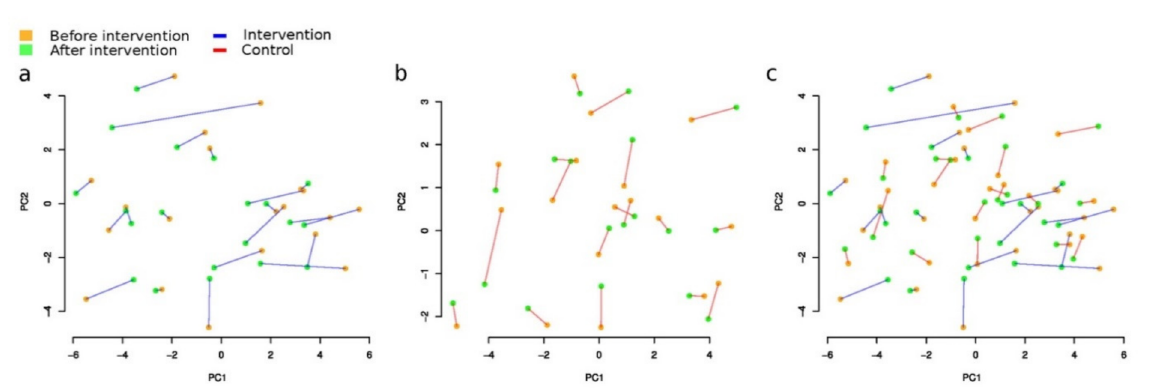
Figure 3. General changes of microbiome composition after the intervention (Aitchison distance): ( a ) intervention (Group A) (PERMANOVA p = 0.01, R 2 = 0.88%); ( b ) control (Group B), ( p = 0.571, R 2 = 0.27%); ( c ) intervention and control groups combined. Please note that the red dots denote the samples before the intervention, and the blue dots, after.